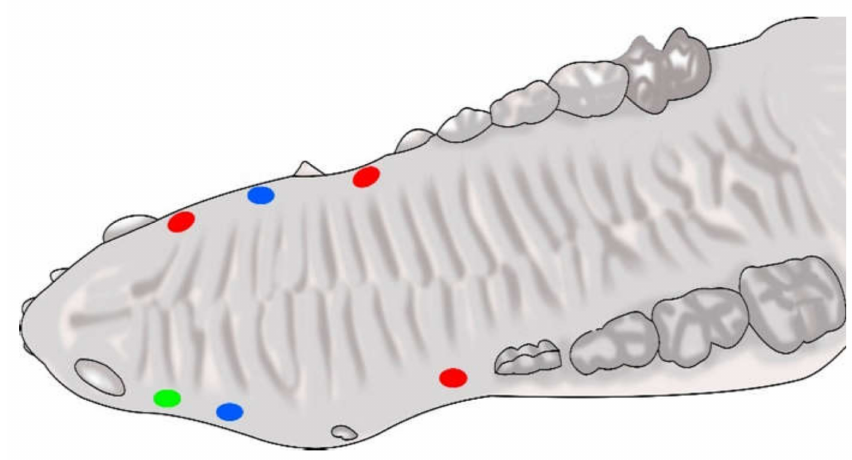
Figure 1. Schematic drawing of one of the pigs on the day of surgery showing: A green circle corresponding to a surgical site that will be left to gingival healing with secondary intention; two blue circles corresponding to surgical sites on which mADMG was subsequently placed; three red circles corresponding to surgical sites on which dADMG was subsequently placed.